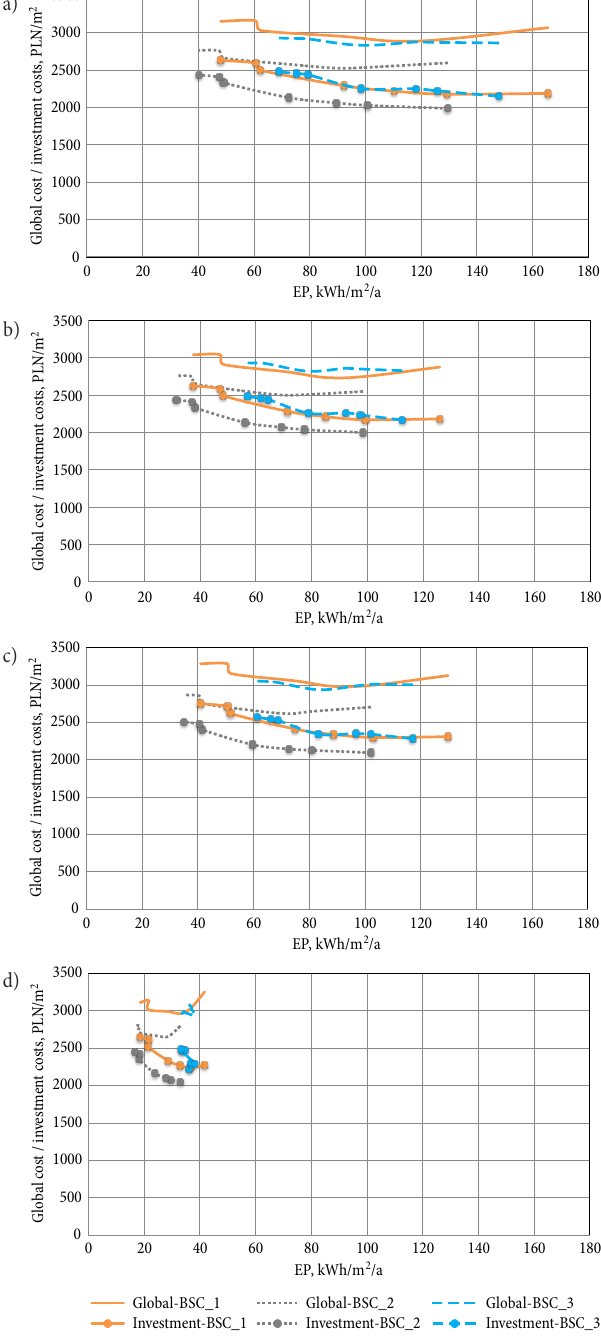
Fig. 4. The variability of global costs for the analysed buildings and the different heat sources in kWh/m 2 /a: a – GCB; b – DH; c – GHP; d –